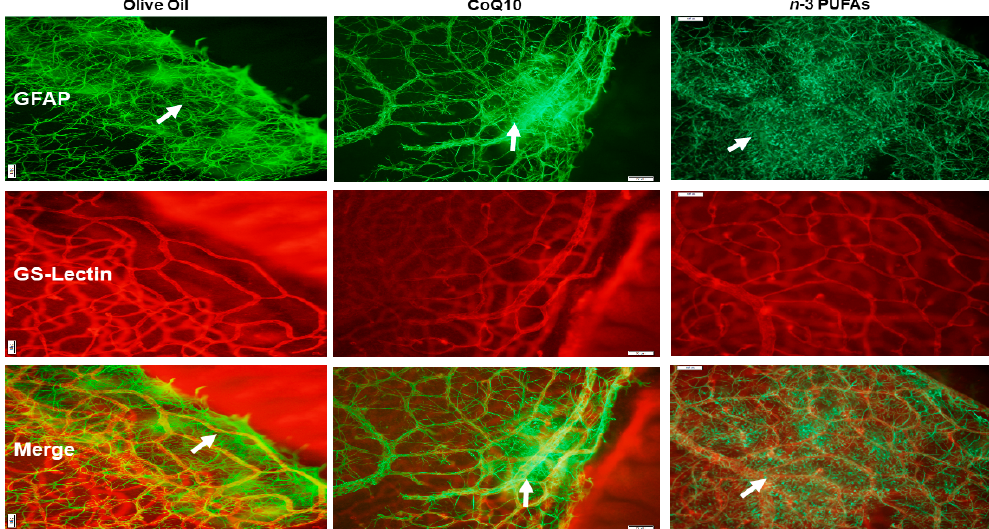
Figure 7. Representative images of retinal flatmounts from 21-day-old rat exposed to 21/12% O 2 IH. Astrocytes and Müller cells were stained for GFAP immunoreactivity (green), and retinal vasculature was stained with isolectin B4, which is a biomarker for endothelial cells (red). Merged images are presented in the bottom panel. Animals were supplemented with olive oil ( left panels ), CoQ10 ( middle panels ), or n -3 PUFAs ( right panels ). Images are 10× magnification, and the scale bar is 100 µM.